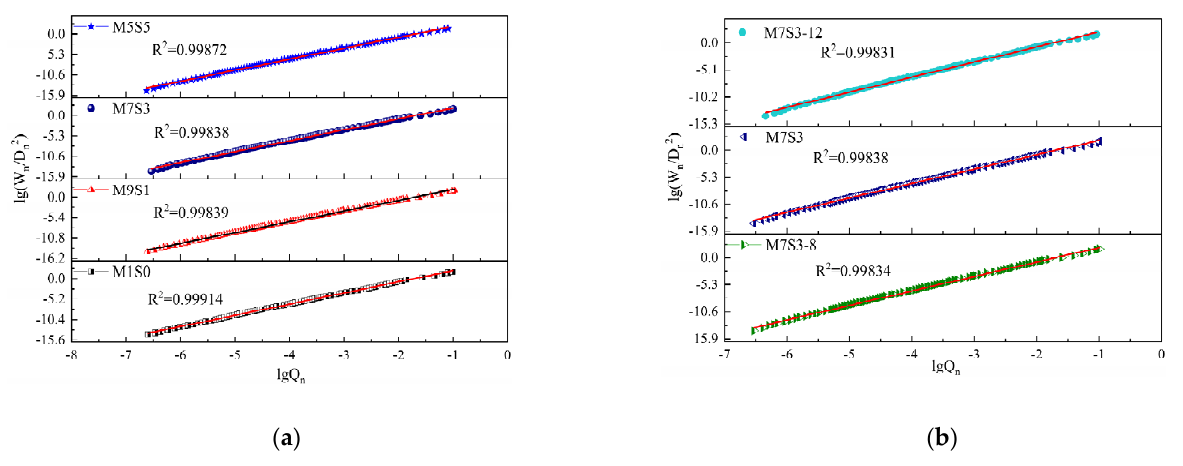
Figure 12. Fractal model scatter plot based on thermodynamic relationships. ( a ) Different Slag Table 5. Significance of the correlation coefficients.